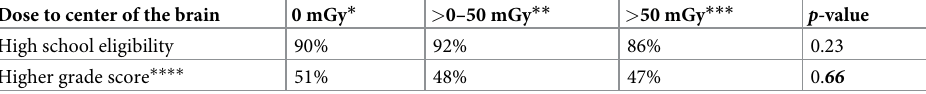
Table 4. Percentages of participants eligible for high school and with higher grade scores in the different dose cat- egories, Chi-square test with 3 categories. Dose to center of the